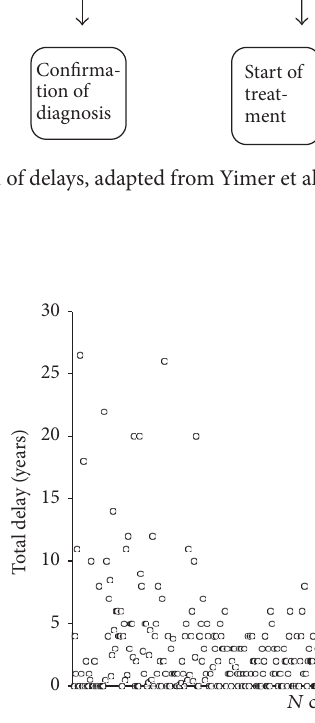
Figure 2: Distributionof total delay in years ( y- axis)among number of cases ( x-